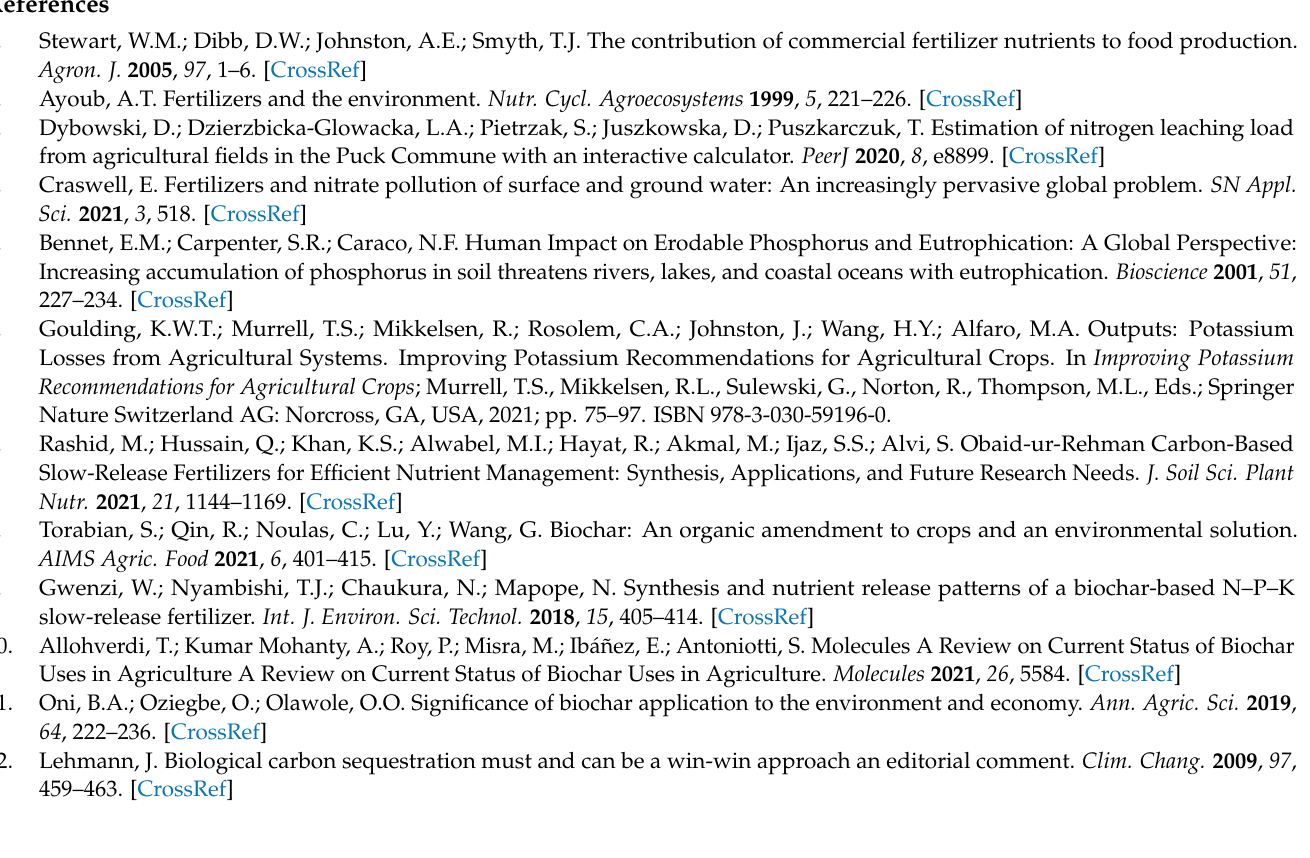
Figure S3: Elution curves of ions/nutrients from soil columns containing 0, 0.5, 1 and 2% biochar under unsaturated conditions using the Equilibrium Exchange (E.E.) model; Figure S4: Elution curves of ions/nutrients from soil columns containing 0, 0.5, 1 and 2% biochar under unsaturated conditions using the Kinetic Exchange (K.E.)